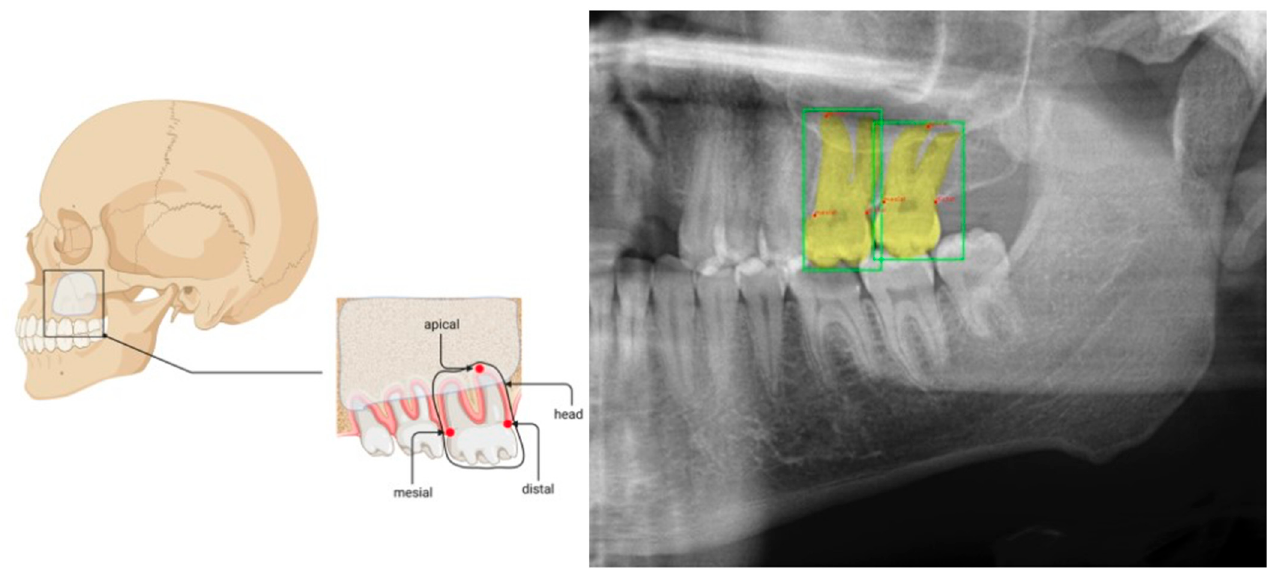
Figure 2. Illustration of molar (boxes) and keypoint (mesial, distal, and apical) settings. Boundary boxes were set according to the polygons drawn by two dentists with more than three years of experience in dental radiograph examinations. The whole panoramic radiographic image was used as the image input. The shown figure was limited to the region of interest for better visualization.